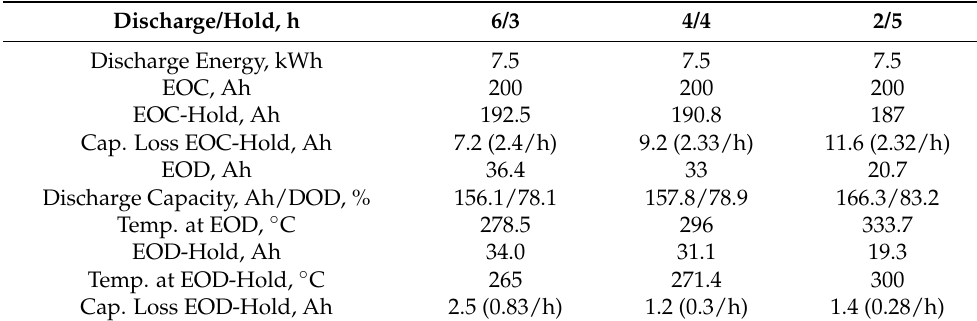
Table 3. SOC, energy and temperatures of the module for 7.5 kWh peak shaving